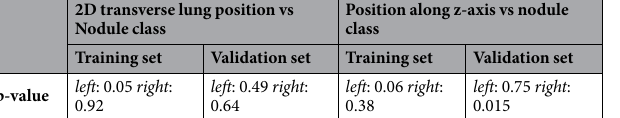
Table 5. The p-values corresponding to the χ 2 test between the diagnostic class of a nodule and its relative position in 2D and 3D (along z-axis). p-value < 0.01 was considered as corresponding to a significant association between the spatial location of a nodule and its diagnostic class.